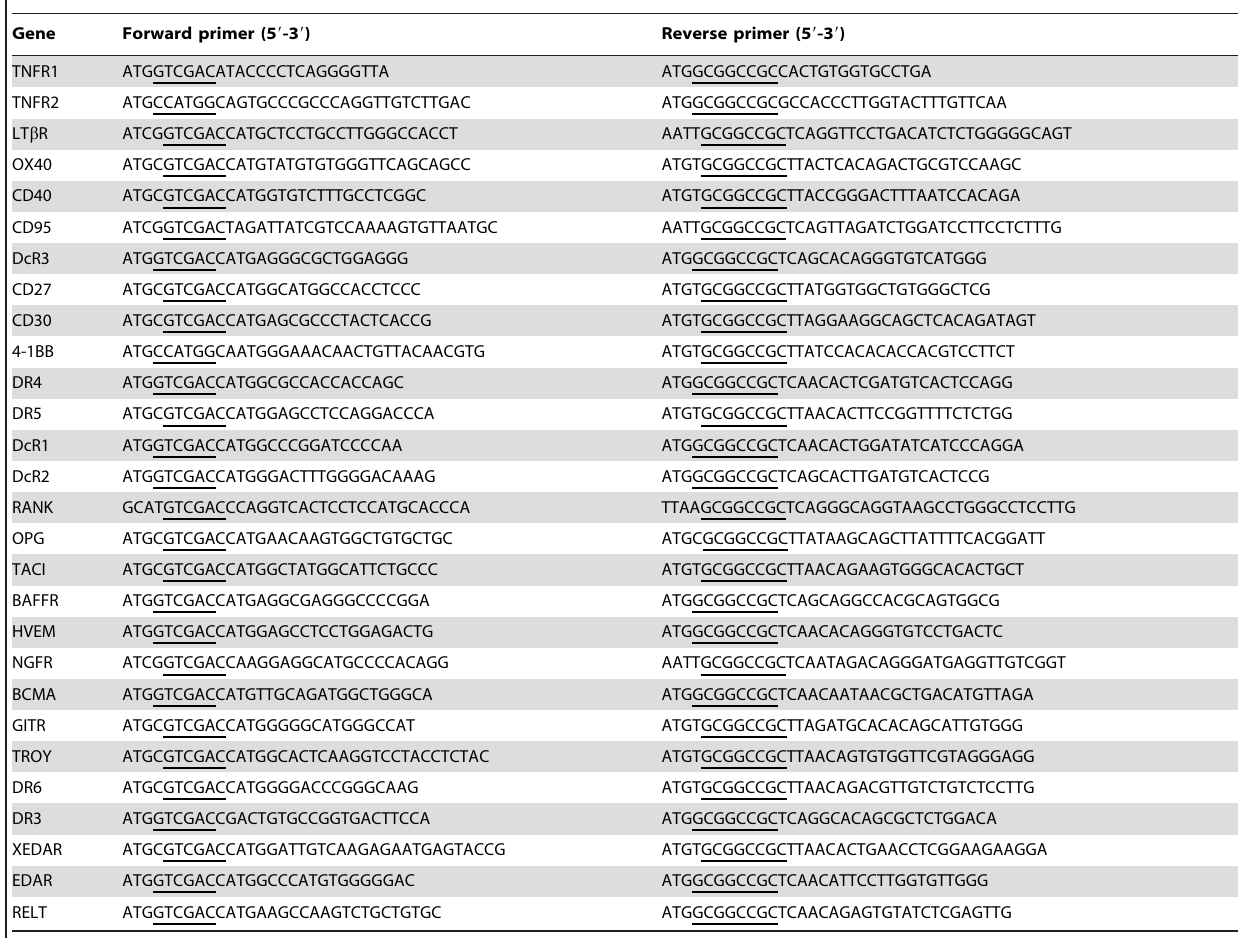
Table 1. Primers for sub-cloning extracellular portions of TNFRSF members into pPC86.